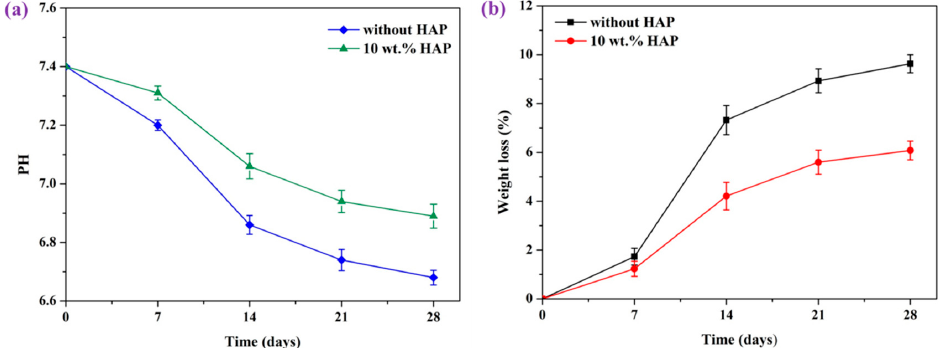
Figure 8. ( a ) pH value of the PEEK/PGA scaffold and PEEK/PGA-10 wt % HAP scaffold during in vitro degradation; ( b ) weight loss of the PEEK/PGA scaffold and PEEK/PGA-10 wt % HAP scaffold after immersing in